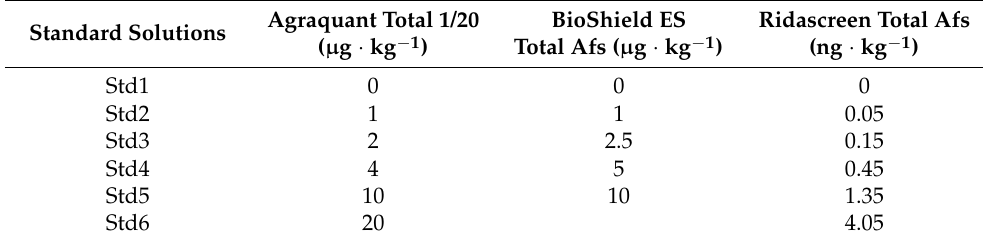
Table 1. Concentrations of standard solutions of the three commercial ELISA kits. Standard